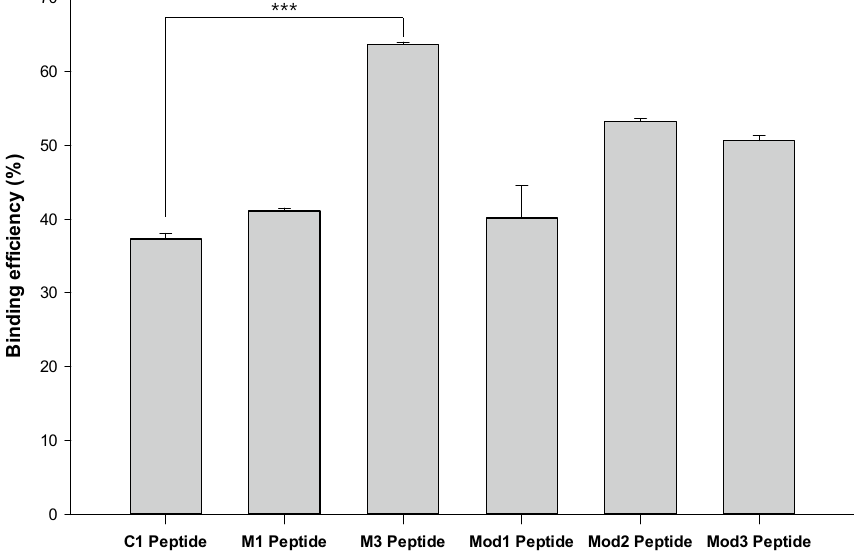
Figure 4. Unique binding affinity ability of the M3 peptide sequence to VDBP-complex. Binding efficiency of one control peptide sequence (C1), two peptide sequences (M1, M3) having high affinity to the VDBP-Complex, and three modified peptide sequences (Mod1, Mod2, and Mod3). The peptide sequences having a high affinity to the control or the VDBP-Complex, respectively, were synthesized, and conjugated with magnetic beads (C1, M1, and M3). Using the C1 sequence as a backbone, one sequence in which the S (Ser) is in front and the F-T (Phe-Thr) part wass in the back (Mod1); one sequence in which the S (Ser) and F-T (Phe-Thr) part appeared in front (Mod2); and one sequence in which the S (Ser), F (Phe), and T (Thr) sequences appeared repeatedly (Mod3), were customized. These three peptide sequences were synthesized and conjugated with magnetic beads. The VDBP-Complex concentration decrease was measured by Bradford assay of the remaining supernatant, after removing the magnetic beads by magnetic field. A p value < 0.001 was considered significant [(protein concentration ± SD) in µg/mL, n = 6]. ***p < 0.001 vs. C1